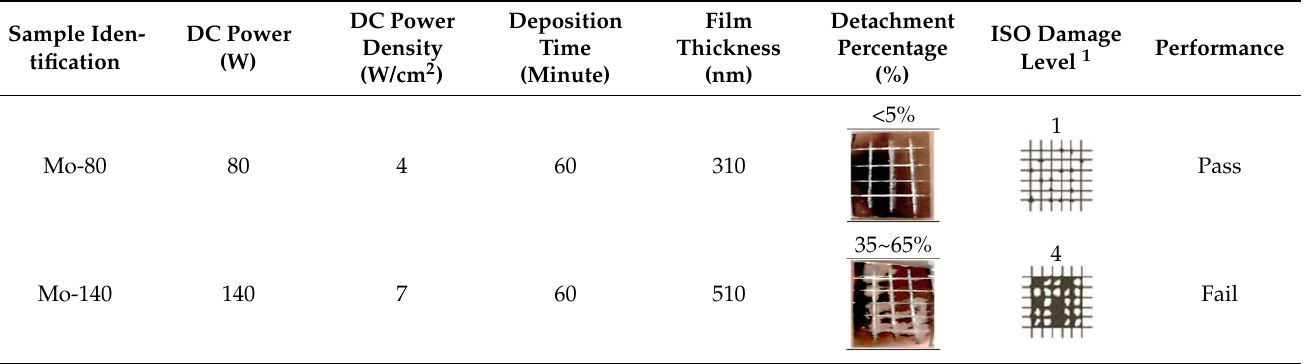
Table 1. Mo sample nomenclature and adhesion results as per ISO standard [31].